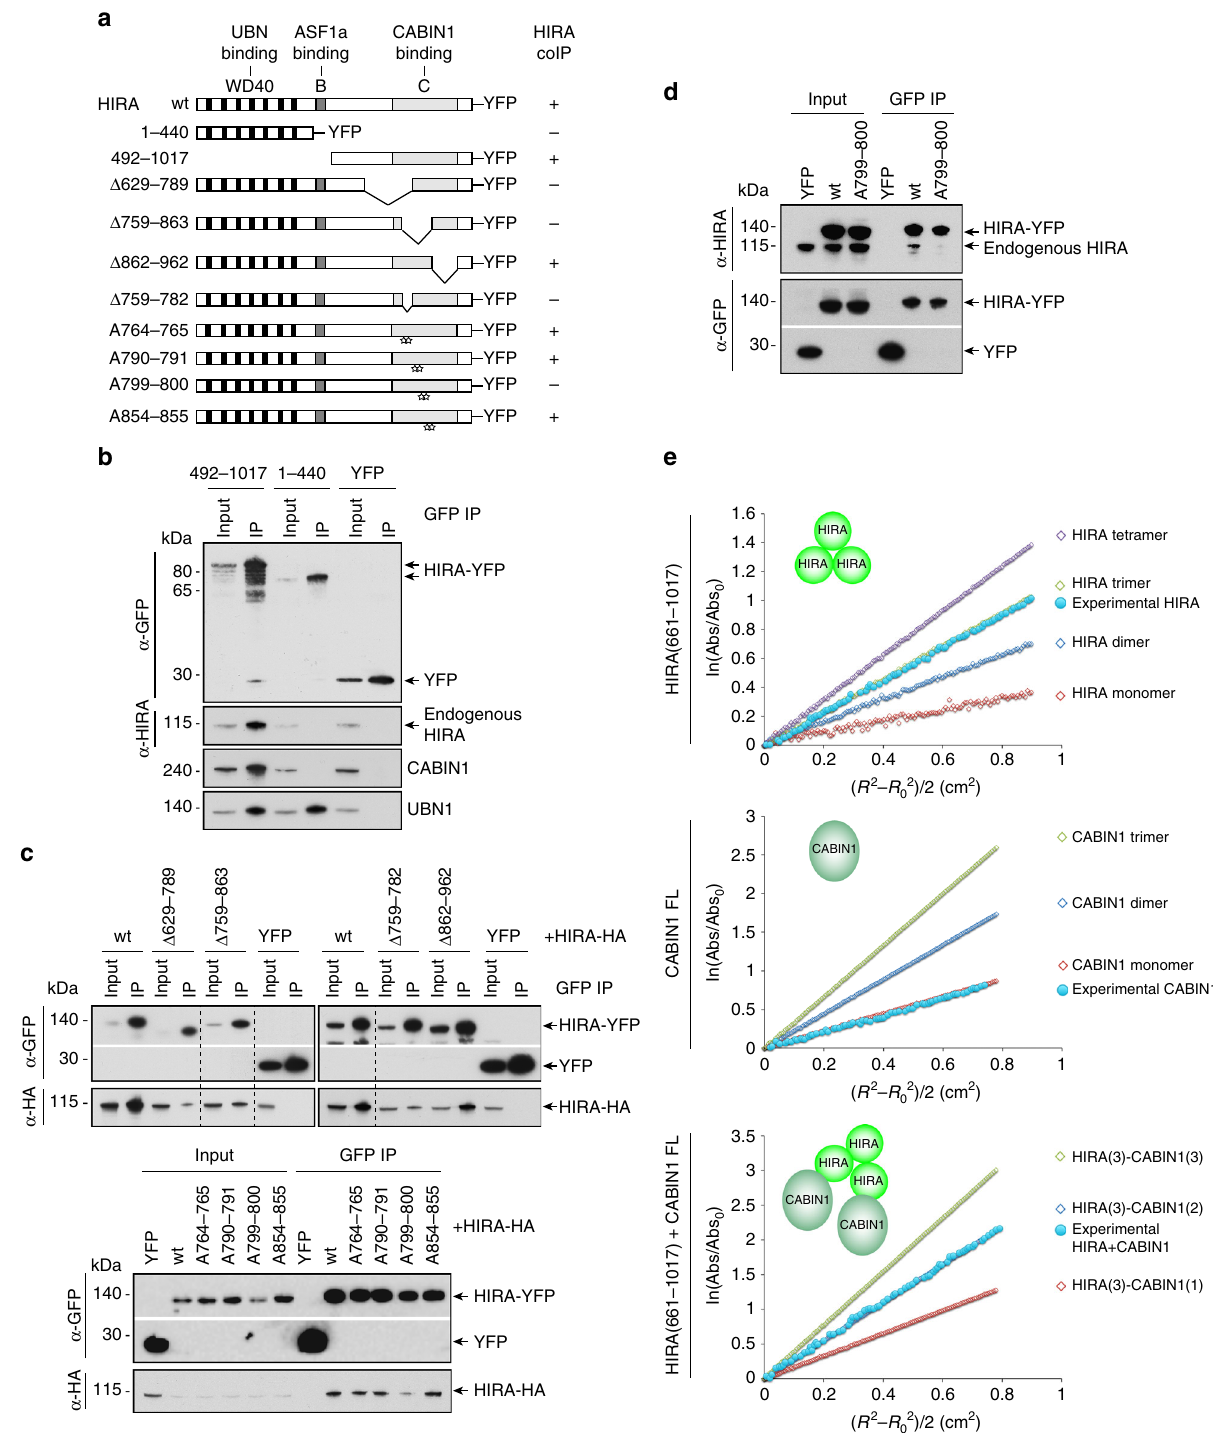
Fig. 1 HIRA homooligomerizes in cells and forms a homotrimer in vitro. a YFP constructs of human HIRA and mutants. The WD40 repeat (aa 1 – 369), B (aa 439 – 475) and C (aa 763 – 963) domains involved in UBN, ASF1a, and CABIN1 interactions, respectively, are shown. Star indicates single amino acid substitution with alanine. The co-immunoprecipitation ef fi ciency of endogenous HIRA or HIRA-HA (HIRA coIP) is indicated for each construct, “ + ” indicates that the ef fi ciency of coIP is similar to the one obtained with the wt HIRA construct and “ − ” indicates that the ef fi ciency of the coIP is decreased. b Western blot analysis of anti-GFP-immunoprecipitates from U2OS nuclear extracts expressing YFP-tagged proteins. c Western blot analysis of anti-GFP- immunoprecipitates from U2OS nuclear extracts expressing both YFP-tagged and HIRA-HA proteins. d Western blot analysis of anti-GFP- immunoprecipitates from U2OS nuclear extracts expressing YFP-tagged proteins. In b , c and d , input corresponds to 10% of nuclear extract used for each experiment. e Equilibrium sedimentation of recombinant proteins HIRA(661 – 1017), CABIN1 full length (FL) and HIRA(661 – 1017) + CABIN1 FL. Theoretical (open symbols) and experimental (closed symbol) curves are shown